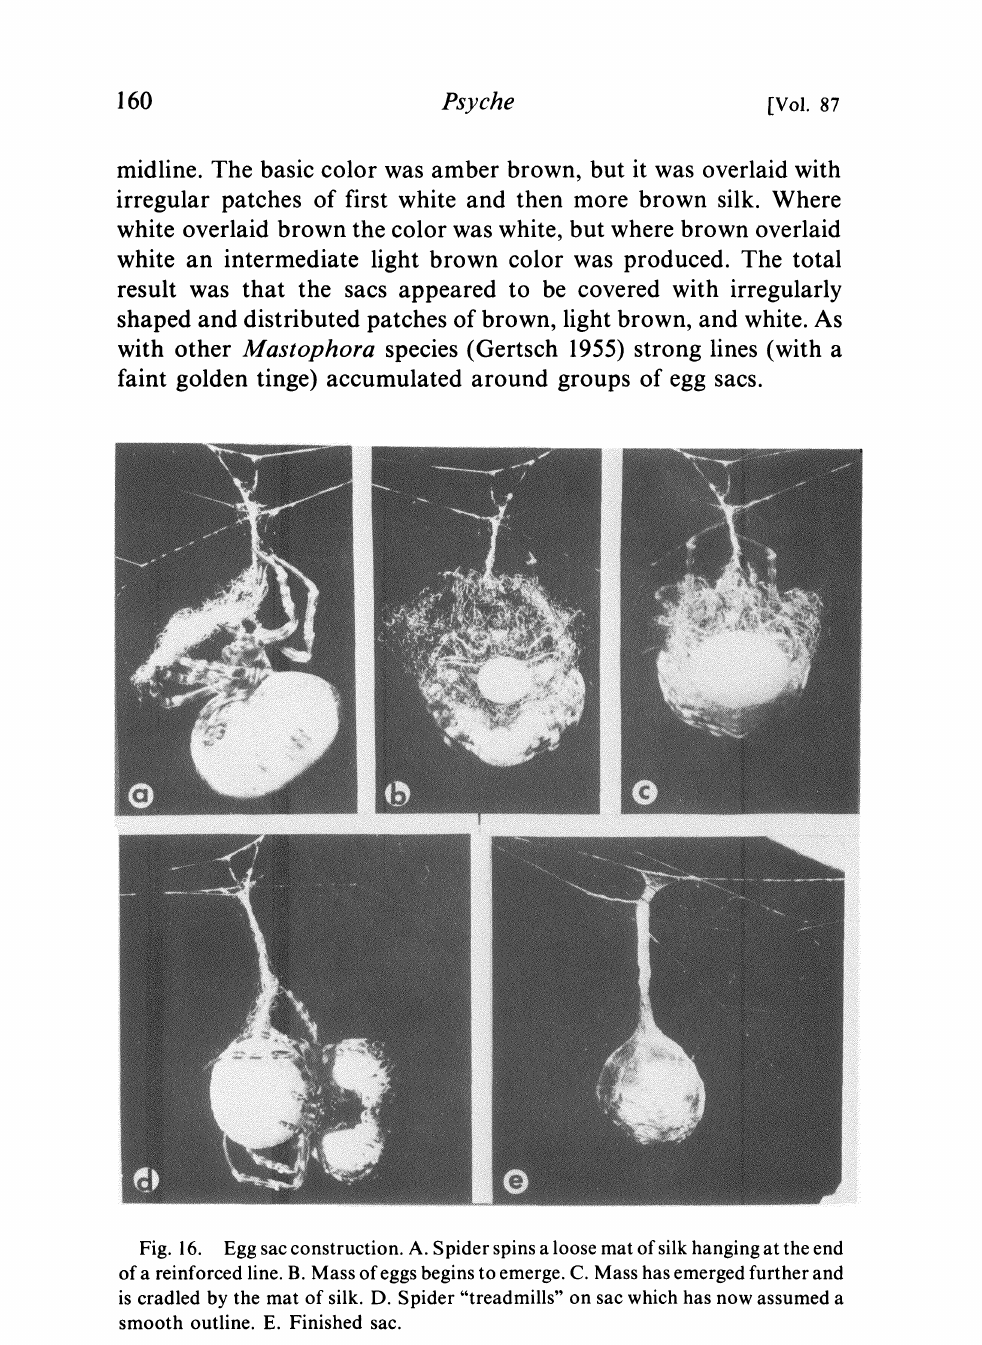
Fig. 16. Egg sac construction. A. Spiderspinsaloosematofsilkhangingattheend of a reinforced line. B. Mass of eggs begins to emerge. C. Mass has emerged further and is cradled by the mat of silk. D. Spider "treadmills" on sac which has now assumed a smooth outline. E. Finished